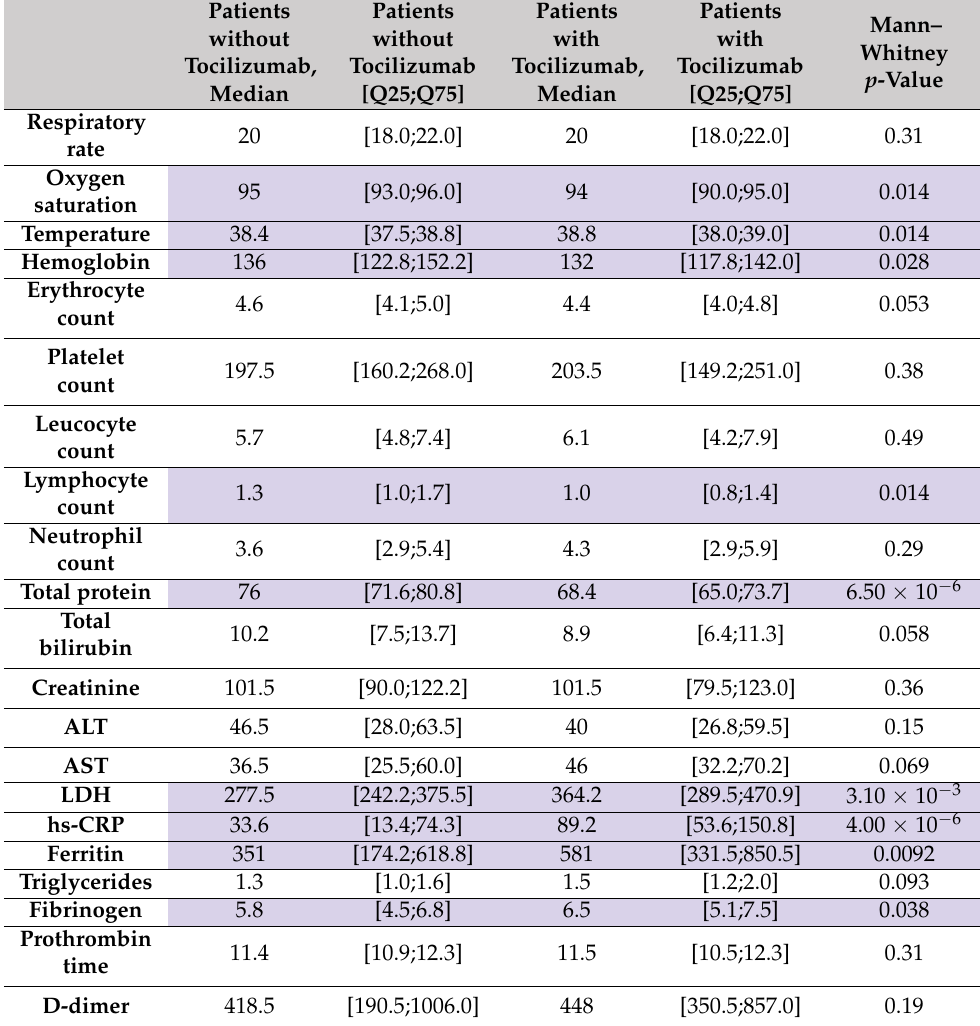
Table 4. Comparison of laboratory parameters between subgroups of patients with and without tocilizumab therapy. Data are presented as median and interquartile range [Q25;Q75]. p -values are presented according to the Mann–Whitney